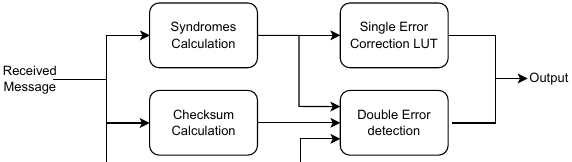
Figure 4. Architecture of the Field Programmable Gate Arrays (FPGA) implementation of the Hamming